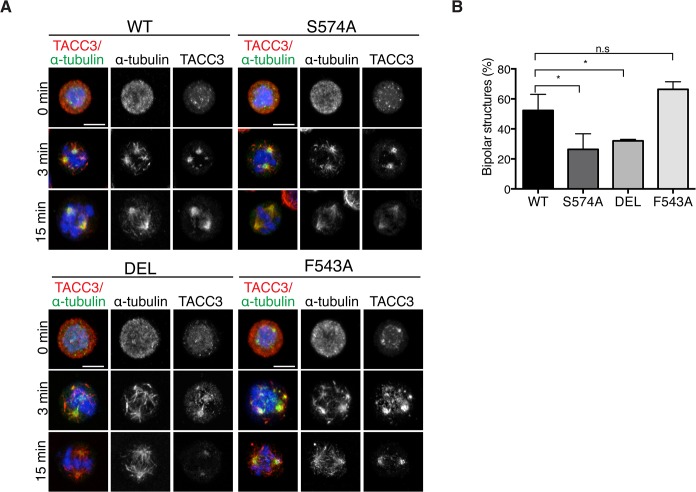
The appearance of bipolar spindles is delayed in S574A and DEL cells following MT regrowth.(A) MT regrowth assays in DT40 cells with genotypes as indicated. MTs were depolymerized by nocodazole and then allowed to recover for 3 or 15 minutes. Note that the mutant TACC3 products accumulate on nascent MTs. Scale bar = 5 μm. (B) Graph depicts percentages of mitotic cells with discernible bipolar spindles after 15 minutes of MT regrowth. n = 3 independent experiments; minimum of 100 cells scored per genotype per experiment. Student t-test (* P = 0.03).